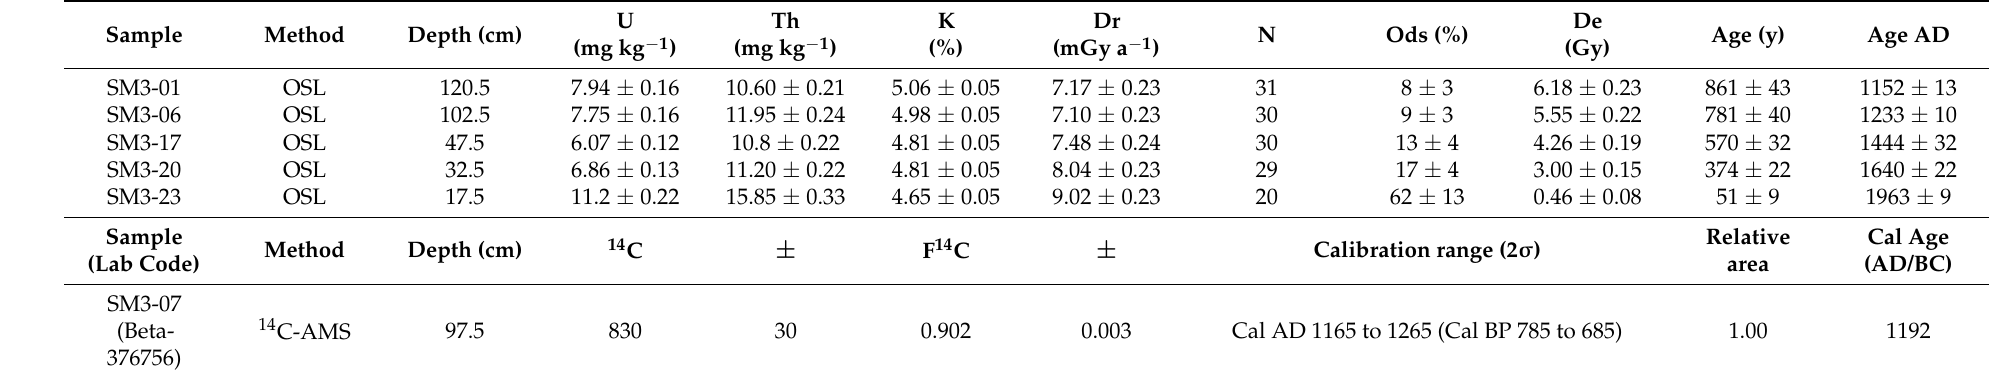
Table 1. Results of the OSL (upper part of the table) and 14 C (lower part) dating methods. For the samples dated by OSL, radioisotope content (U, Th, and K), estimated dose rate (Dr) and (and error), the calibration probability ranges, the relative area for each interval, and the age calculated by the age–depth